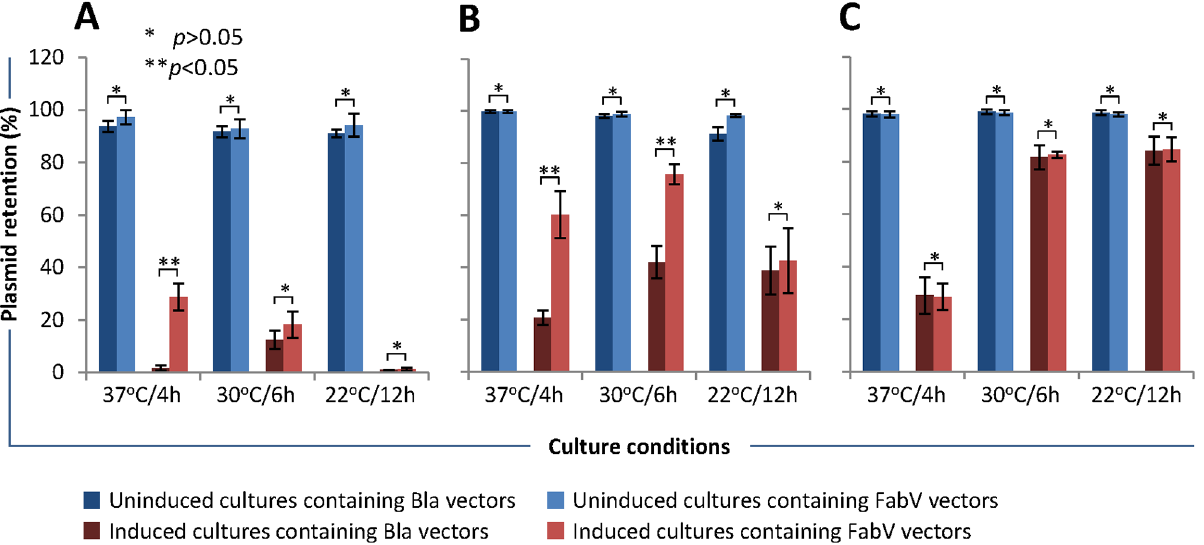
Fig 5. Comparison of plasmid stability/retention between Bla and FabV vectors. BL21(DE3) cells were transformed with Bla or FabV vectors and uninduced and IPTG -induced cultures were grown at 37°C/4h, 30°C/6h, and 22°C/12 h in presence of Ampicillin (for bacteria containing Bla vectors) or Triclosan (for bacteria containing FabV vectors). Cultures were diluted and plated on non-selective LB agar plates. After 18 h incubation at 30°C, 100 colonies were replica patched on non-selective and selective (with Ampicillin or Triclosan) LB agar plates, incubated at 30°C for 18 h, and counted. (A) cultures expressing P24 protein; (B) cultures expressing Nef protein; (C) cultures expressing Vif protein. Error bars show standard deviations calculated from three independent experiments each performed in duplicate.